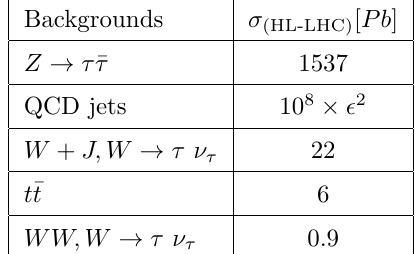
Figure 3 . Total cross sections for the process pp → H i → τ ¯ τ at the HL-LHC with